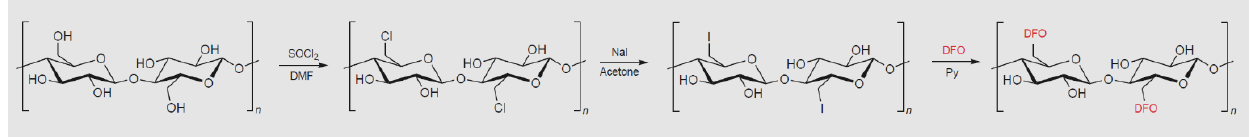
Figure 3. Synthesis scheme for the DFO-paper preparation. (Adapted with permission from [5], Copyright 2017 Springer Nature)